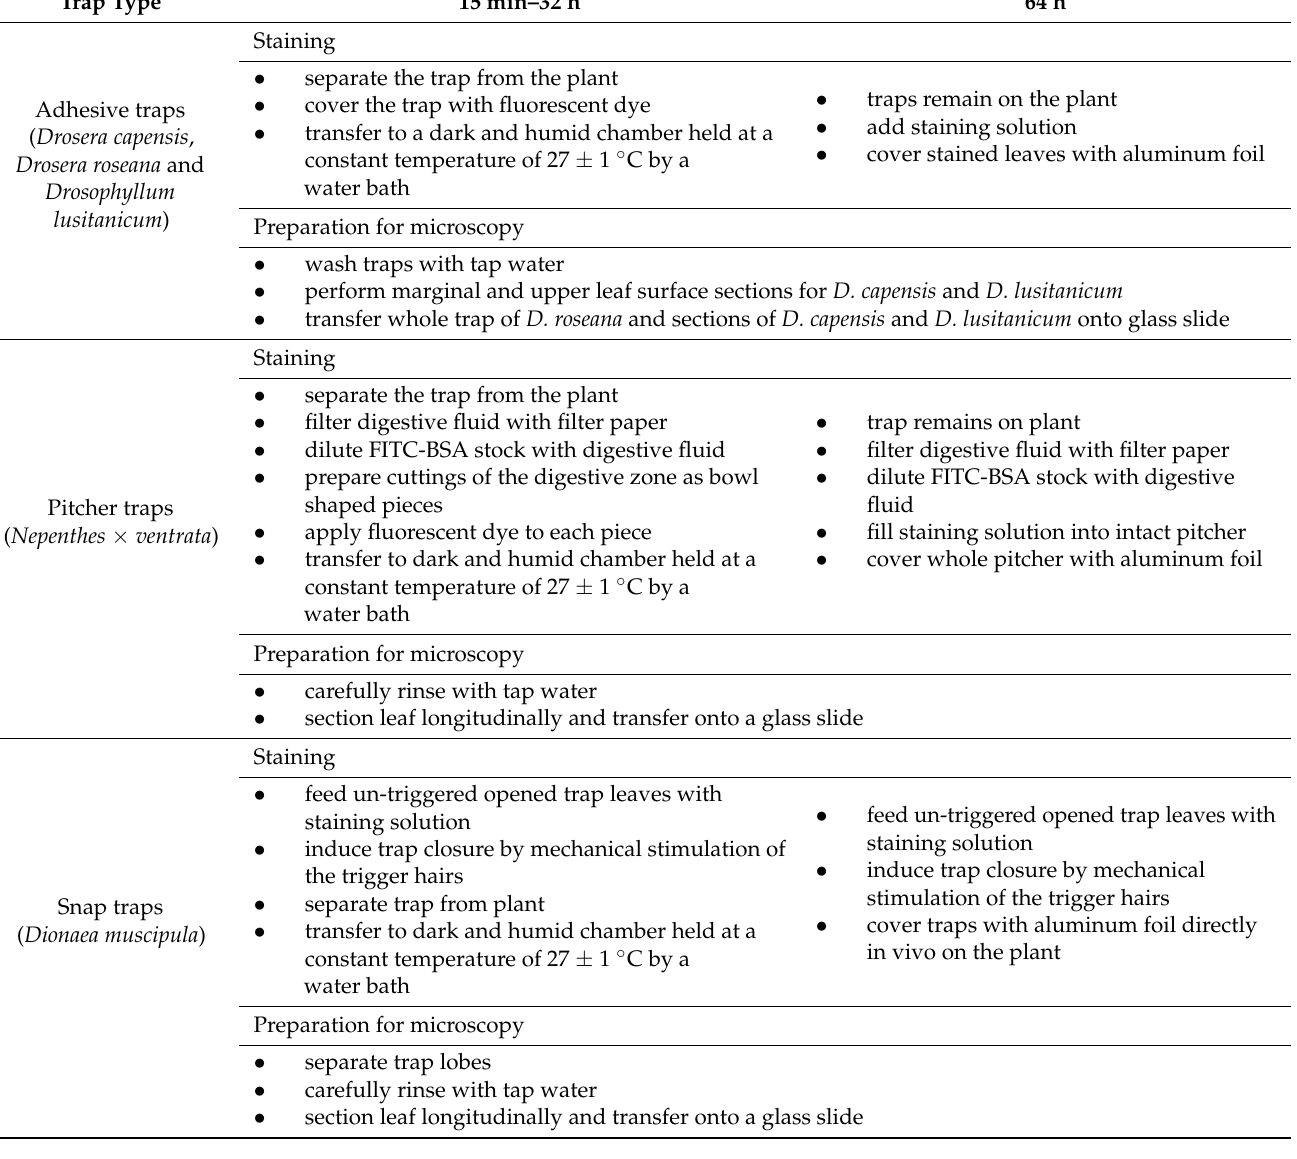
Table 3. Staining and preparation for microscopy itemized by trap type and plant species. Trap